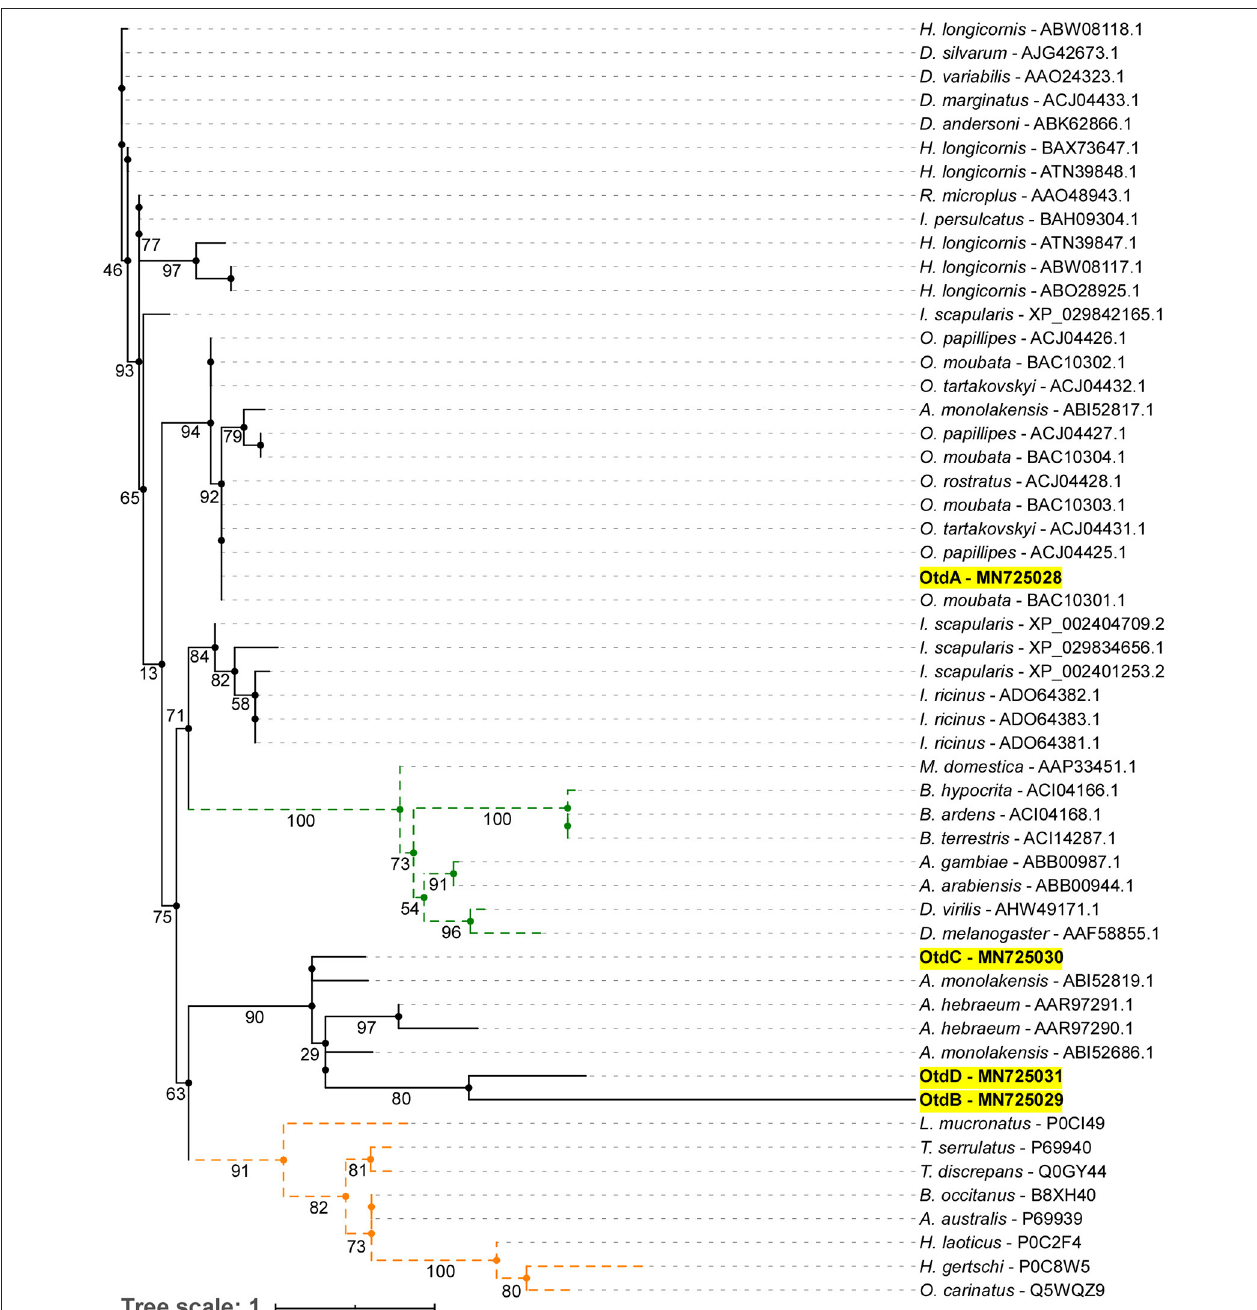
FIGURE 3 | Phylogenetic tree of mature arthropod defensins. Maximum likelihood tree showing mature protein region of defensins from ticks and insects, and defensin-like scorpion toxins. Bootstrap values (1,000 bootstraps) are shown at the nodes. Names highlighted in yellow represent the O. turicata defensins (OtdA, OtdB, OtdC, and OtdD) introduced in this manuscript. Dotted orange lines represent scorpion toxin, defensin-like sequences, and dotted green lines represent insect defensin